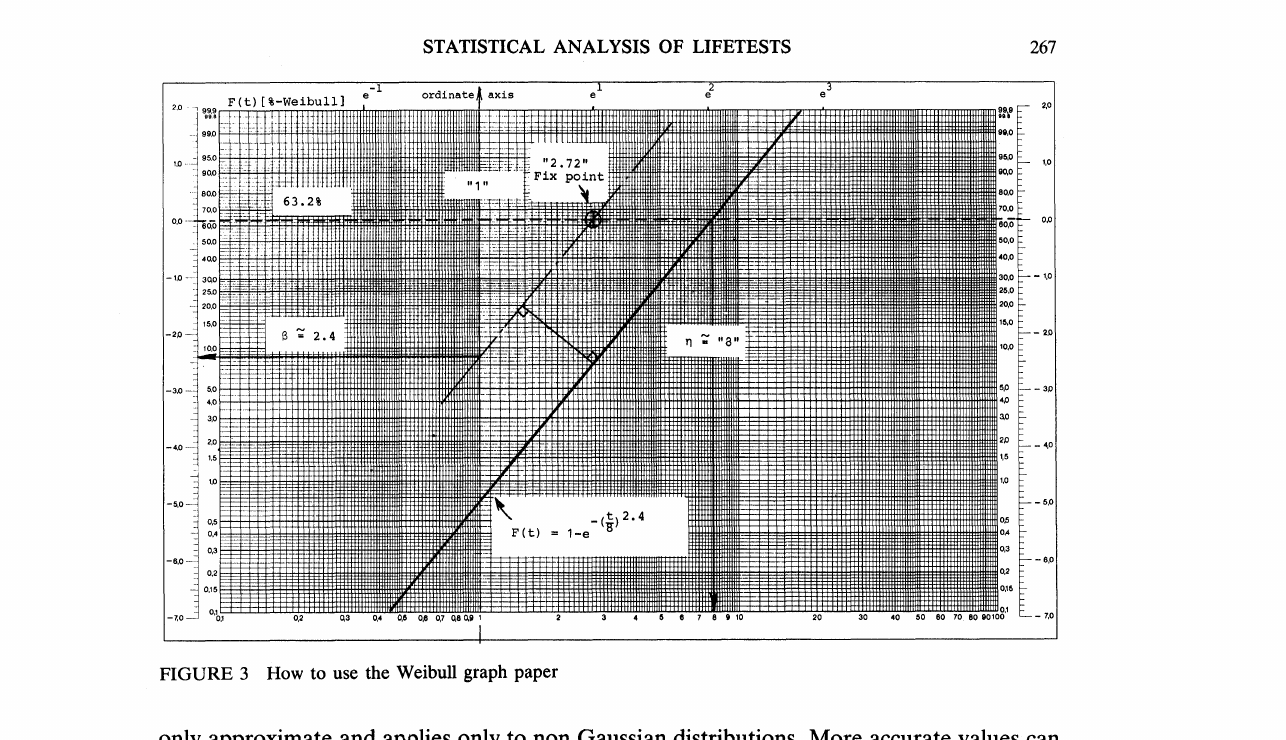
FIGURE 3 How to use the Weibull graph